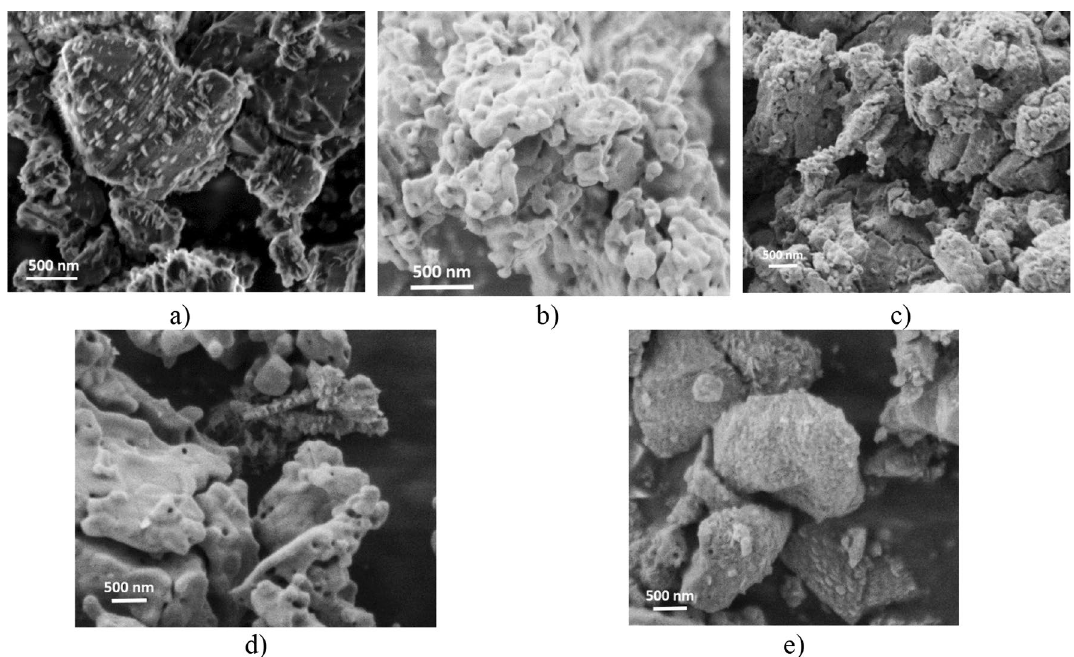
Figure 2. Morphological investigations of oxidized AlN powders. ( a) reference—without oxidization (O_0), ( b ) 3 h oxidization (O_3), ( c ) 6 h oxidization (O_6), ( d ) 10 h oxidization (O_10) and ( e ) 20 h oxidization